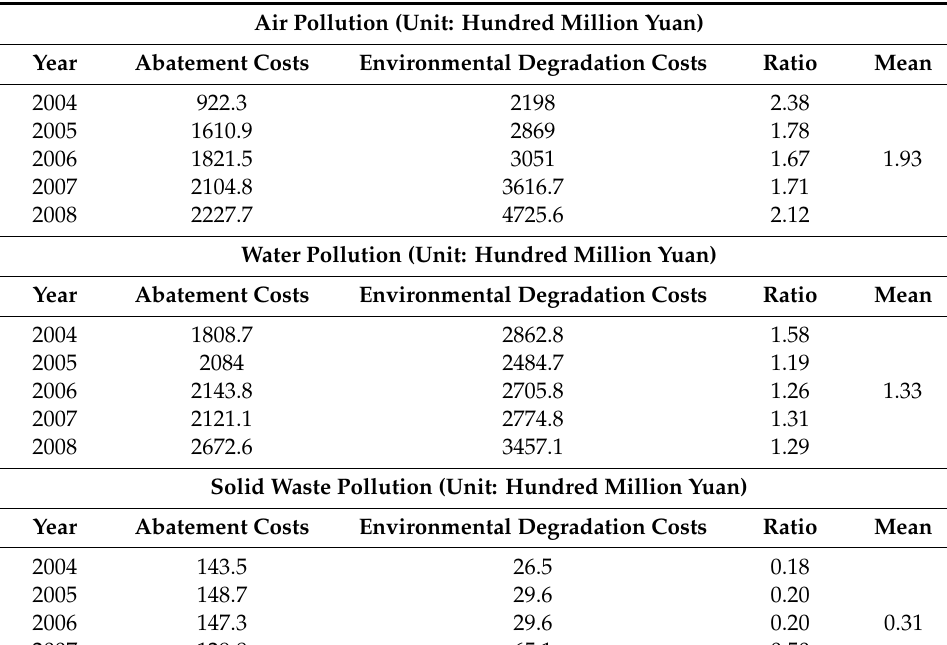
Table 7. The accounting result of environmental costs in China from 2004–2008.